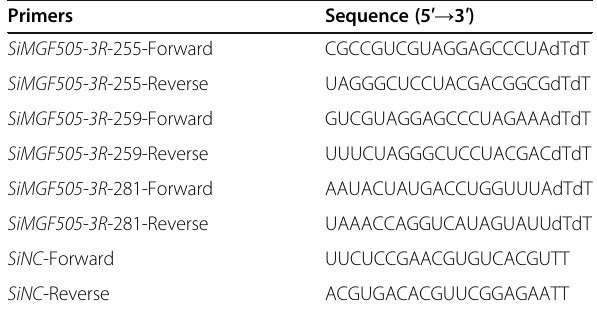
Table 2 SiRNA sequences used in this